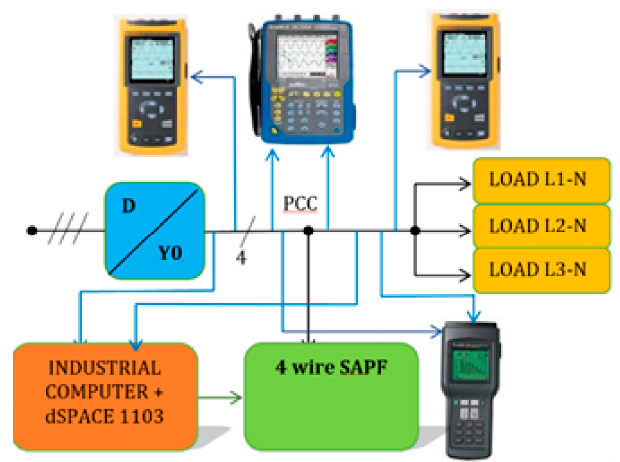
Figure 6. The structure of the experimental setup.